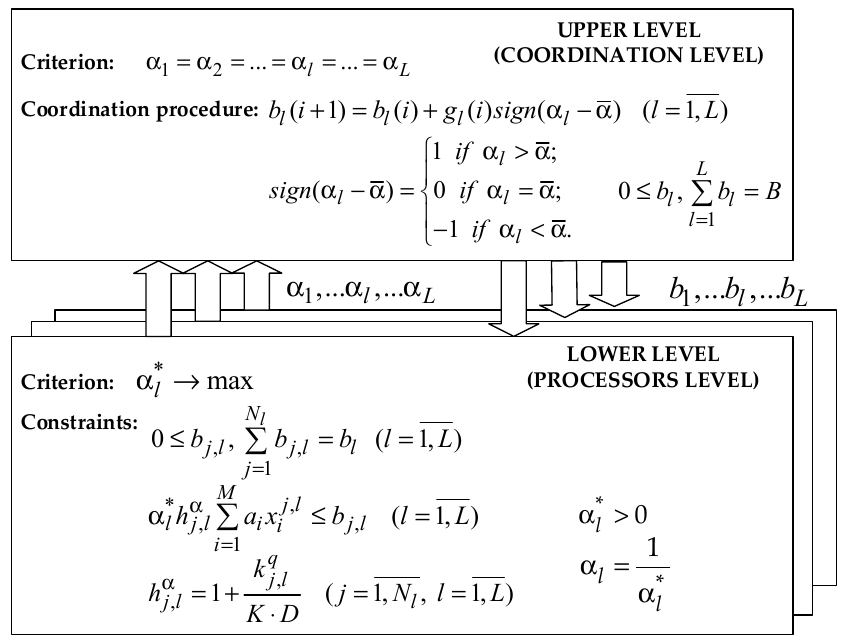
Figure 1. The scheme of the two-level hierarchical queue management method based on priority and balancing.